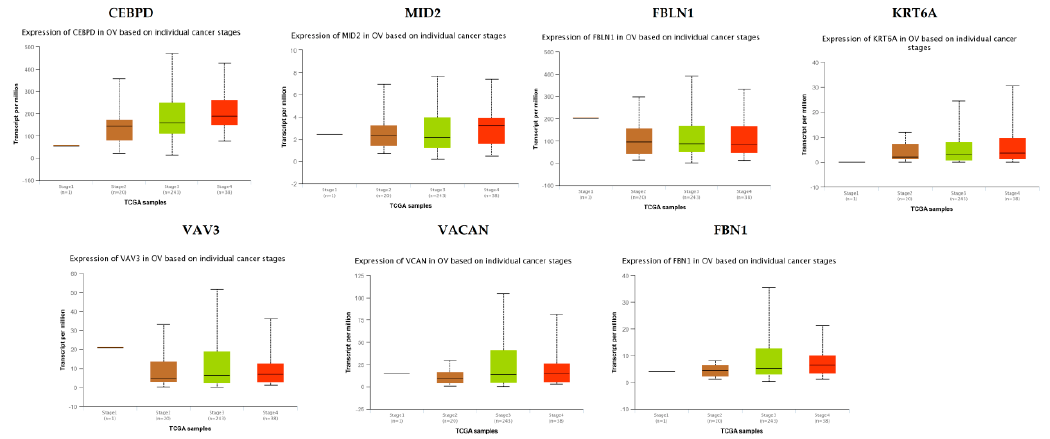
Figure 16. Validation of the expression of hub genes in TCGA database. High expression of hub genes in stages 3 and 4. CEBPD: CCAAT enhancer binding protein delta; OV: ovarian cancer.